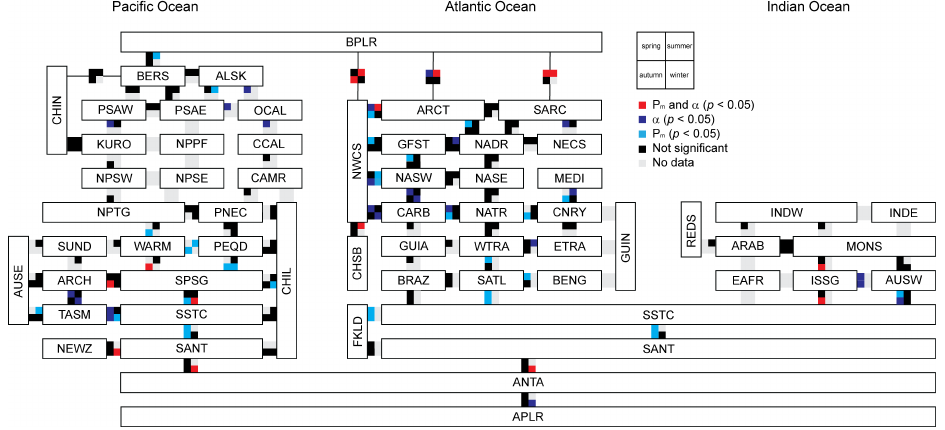
Figure 2. Relationships of photosynthesis versus irradiance (P-I) parameters between adjacent biogeographic provinces. Seasonal relationships are indicated by colour blocks, with significant differences ( p < 0.05) denoted for the initial slope ( α B ) and assimilation number ( P B m ) of the P-I curve (red), α B only (dark blue) and P B m only (light blue). Comparisons were not available for the coastal areas of Africa (EAFR) and India (INDE), two regions in the North Pacific Ocean (NPPF, NPSE) and some seasons in other biogeographic regions due to lack of data (light grey). Biogeographic provinces are listed in Appendix